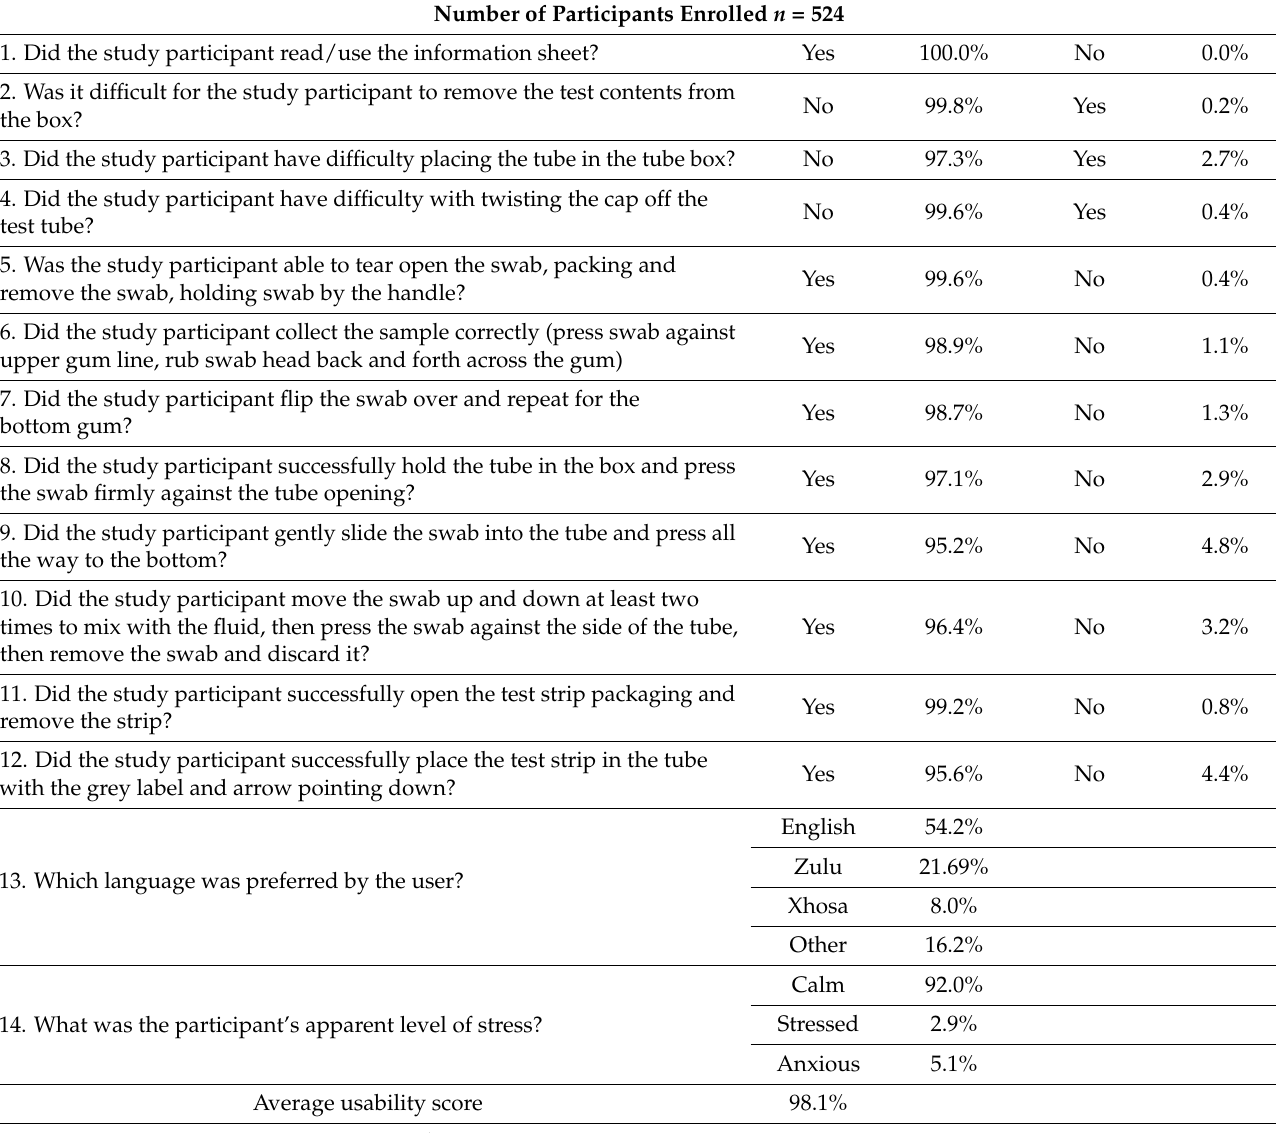
Table 2. Usability